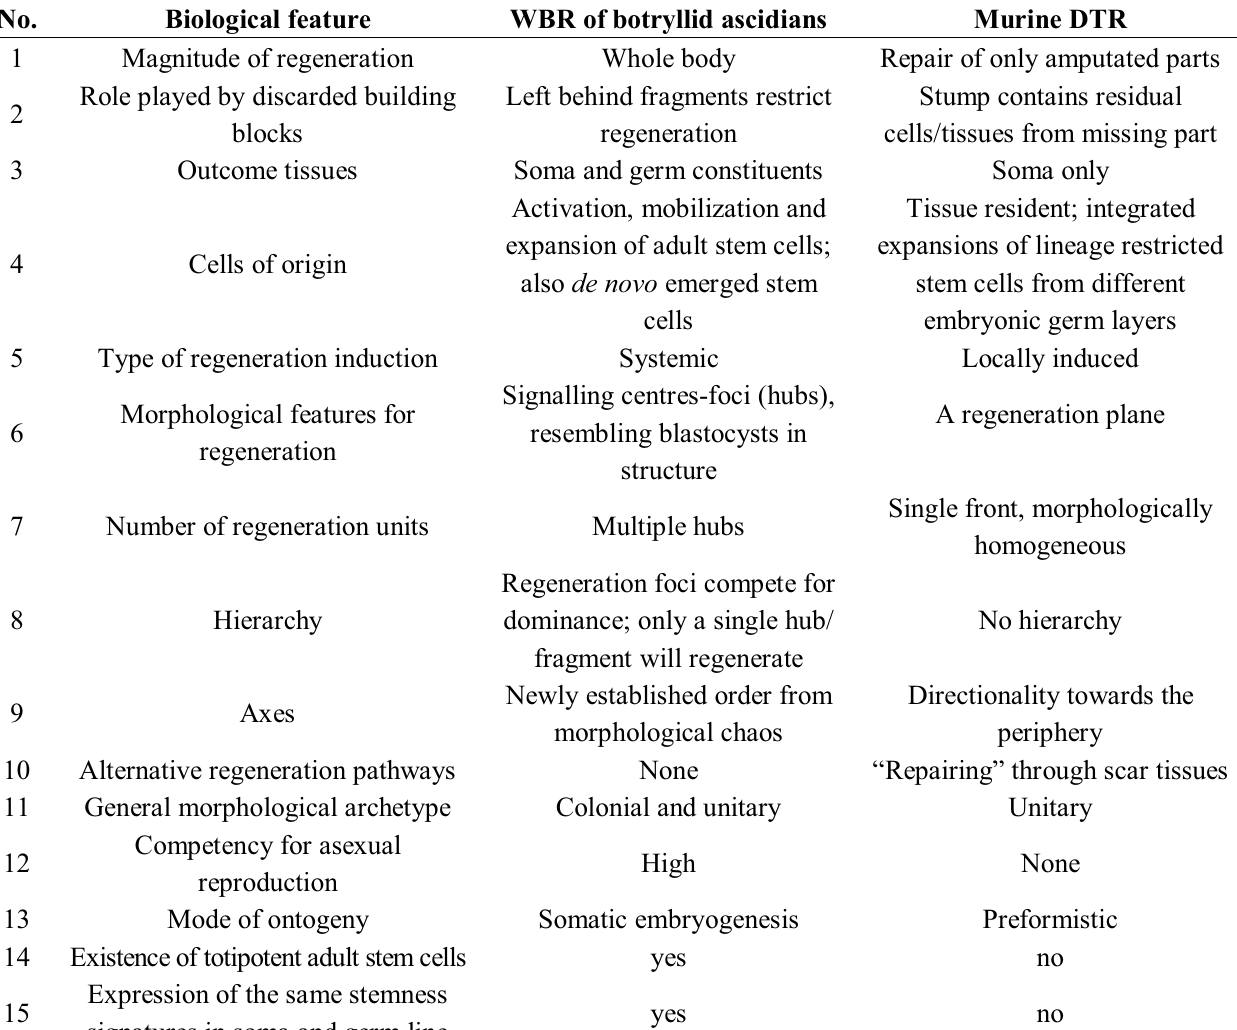
Table 1. Biological features assigned to the (cid:179) stars and stripes (cid:180) pole strategies of metazoans (cid:180) regeneration, following the two model regeneration cases: the whole body regeneration (WBR) of botryllid ascidians (the allegory of (cid:179) stars (cid:180) in the American flag) and the murine digit tip regeneration (DTR) (the allegory of (cid:179) strips (cid:180) in the American flag). The following is based on [3,17,18,20,50 (cid:177) 55]; and unpublished